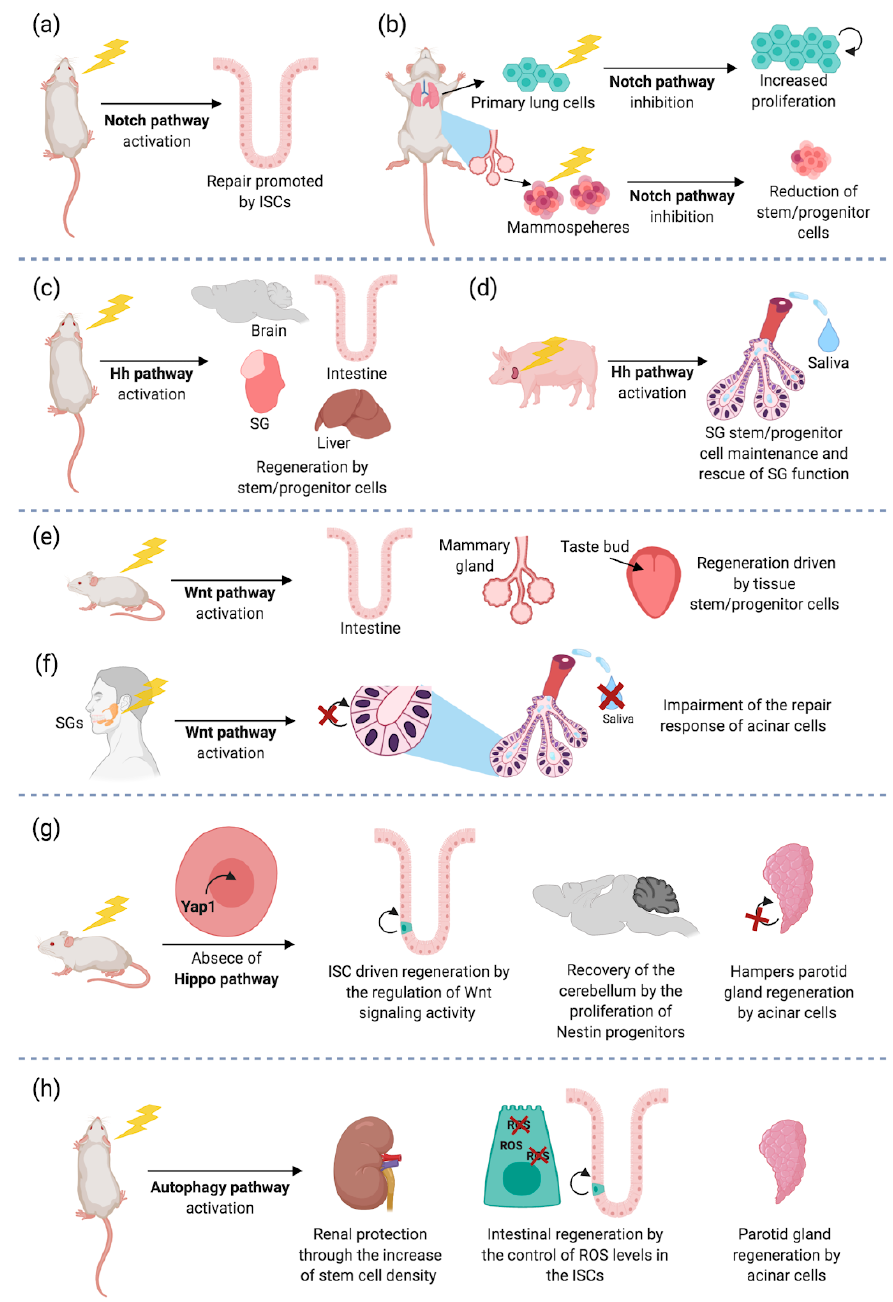
Figure 2. Principal signaling pathways involved in the response of stem/progenitor cells to irradiation. ( a ) The activation of the Notch signaling pathway in intestinal stem cells (ISCs) drives the post-irradiation in vivo regeneration of the murine gut. ( b ) Notch inhibition hampers the maintenance of stem/progenitor cells of the murine mammary gland after irradiation in vitro, while it promotes the response of mouse lung stem/progenitor cells. ( c ) The activity from the hedgehog (Hh) signaling pathway orchestrates the regeneration driven by stem/progenitor cells in the mouse brain, intestine, salivary gland (SG), and liver. ( d ) SG radiation-induced dysfunction is rescued by cues from the Hh signaling pathway in a pig model. ( e ) Activation of the Wnt canonical pathway results in stem/progenitor driven regeneration of the murine intestine, taste bud, and mammary gland post-irradiation. ( f ) The activation of the Wnt pathway hampers the repair response of human acinar cells to irradiation. ( g ) The absence of Hippo signaling through Yap1 nuclear translocation promotes the intestinal and cerebellar recovery after irradiation. However, nuclear Yap1 localization impairs the parotid gland regeneration. ( h ) The activation of the autophagy pathway protects the mouse kidney, intestine, and parotid gland from irradiation. Reactive oxygen species (ROS). Created with